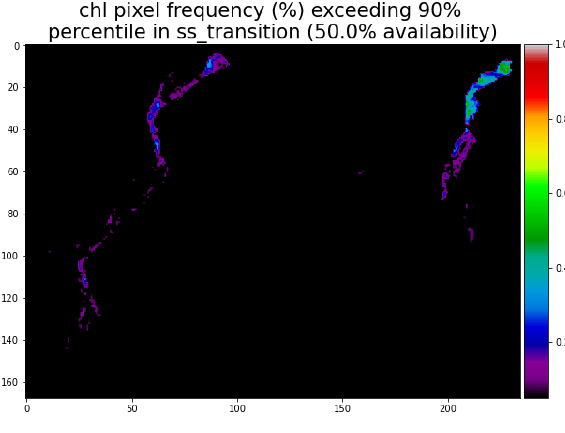
Figure 17. CHLOROPHYLL-A spatial pattern map in spring - summer transition